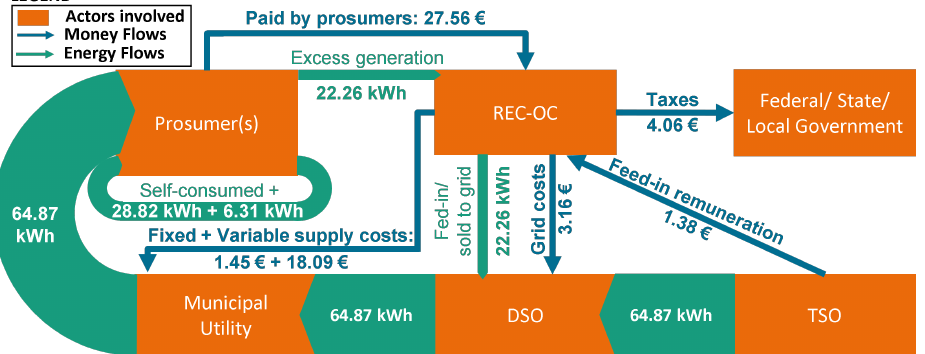
Figure 6. Energy and money flows between the various actors standardized for 100 kWh consumption. Exemplary for the full prosumership flexibility (FP_flex) scenario.